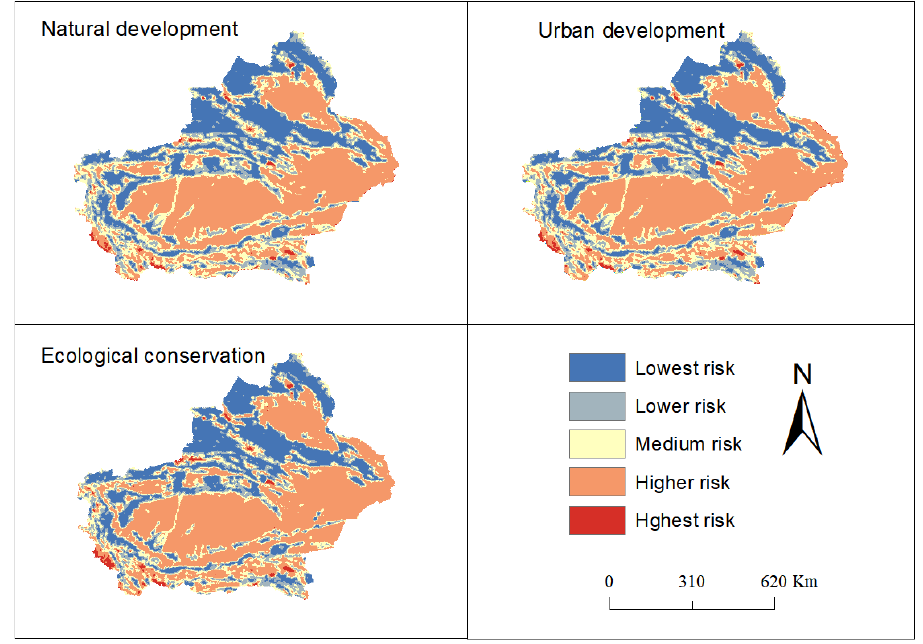
Figure 5. Spatial distribution of landscape ecological risk in Xinjiang in 2030.